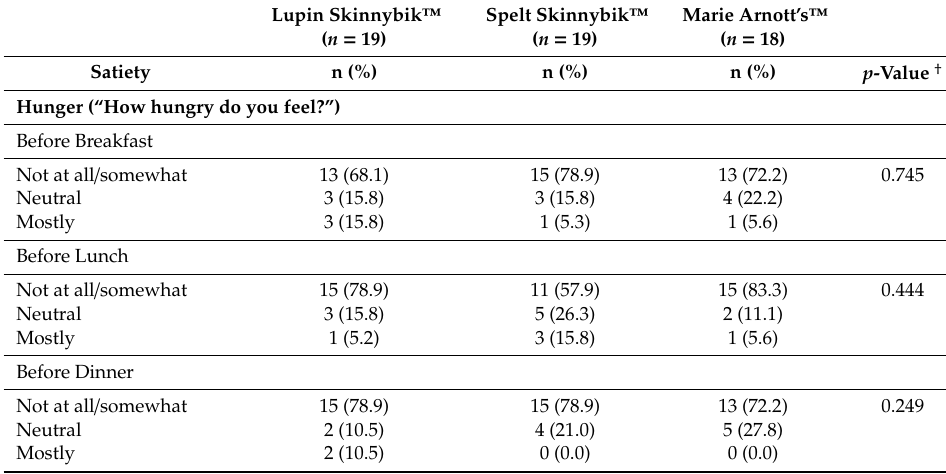
Table 3. Di ff erences in satiety, palatability and bowel function among patients consuming di ff erent types of